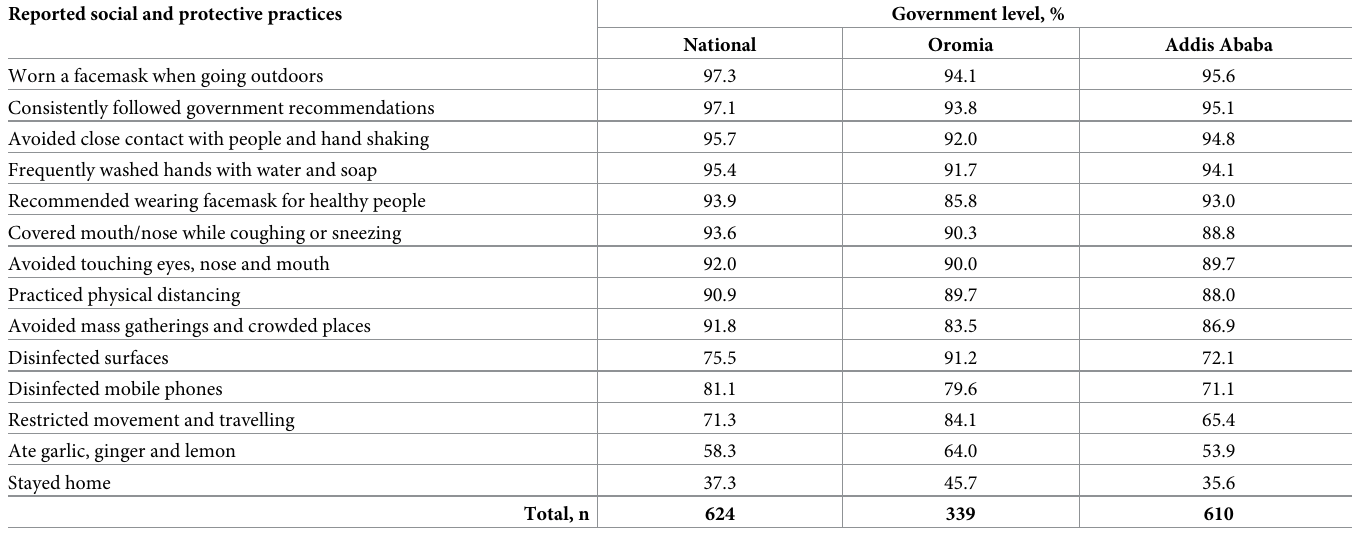
Table 2. Distribution of respondents reported the social and protective measures in response to COVID-19 by government level (n = 14 items), Addis Ababa, June 2020. Reported social and protective